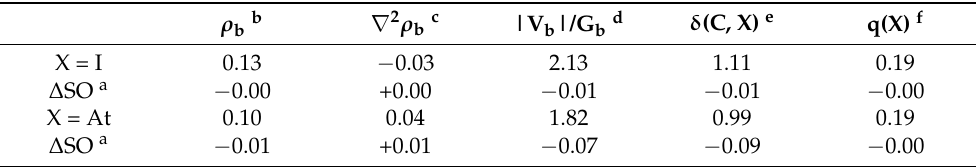
Table 2. Selected QTAIM descriptors (in a.u.) obtained at the 2c-PW6B95-D3/TZVPPD level of theory for C–X bonds in C 6 X 6 species (X = I,